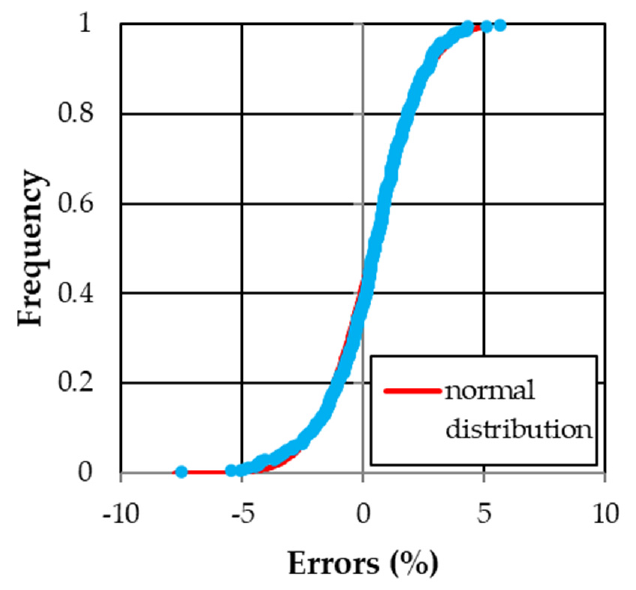
Figure 4. Frequency distribution of the errors E in the estimate of f applying Equation (9a) to the data by Ferro and Giordano [31].